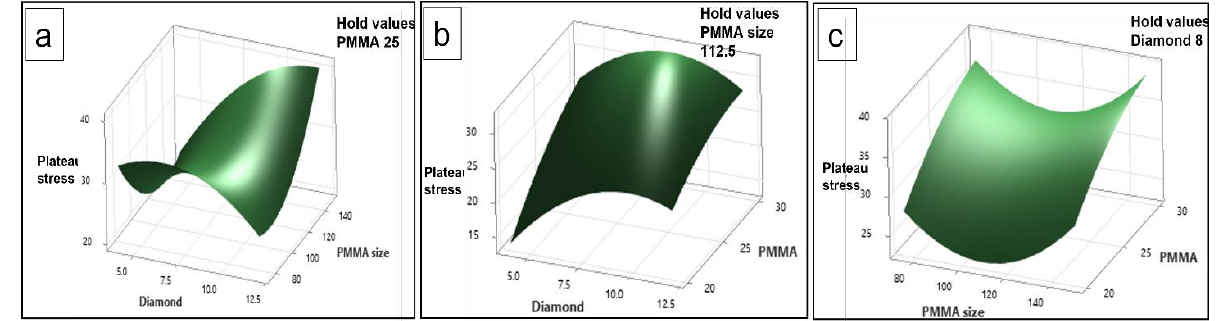
Figure 15. Surface plot of plateau stress vs. ( a ) PMMA size, diamond content, ( b ) PMMA and diamond content, and ( c ) PMMA size, PMMA content.